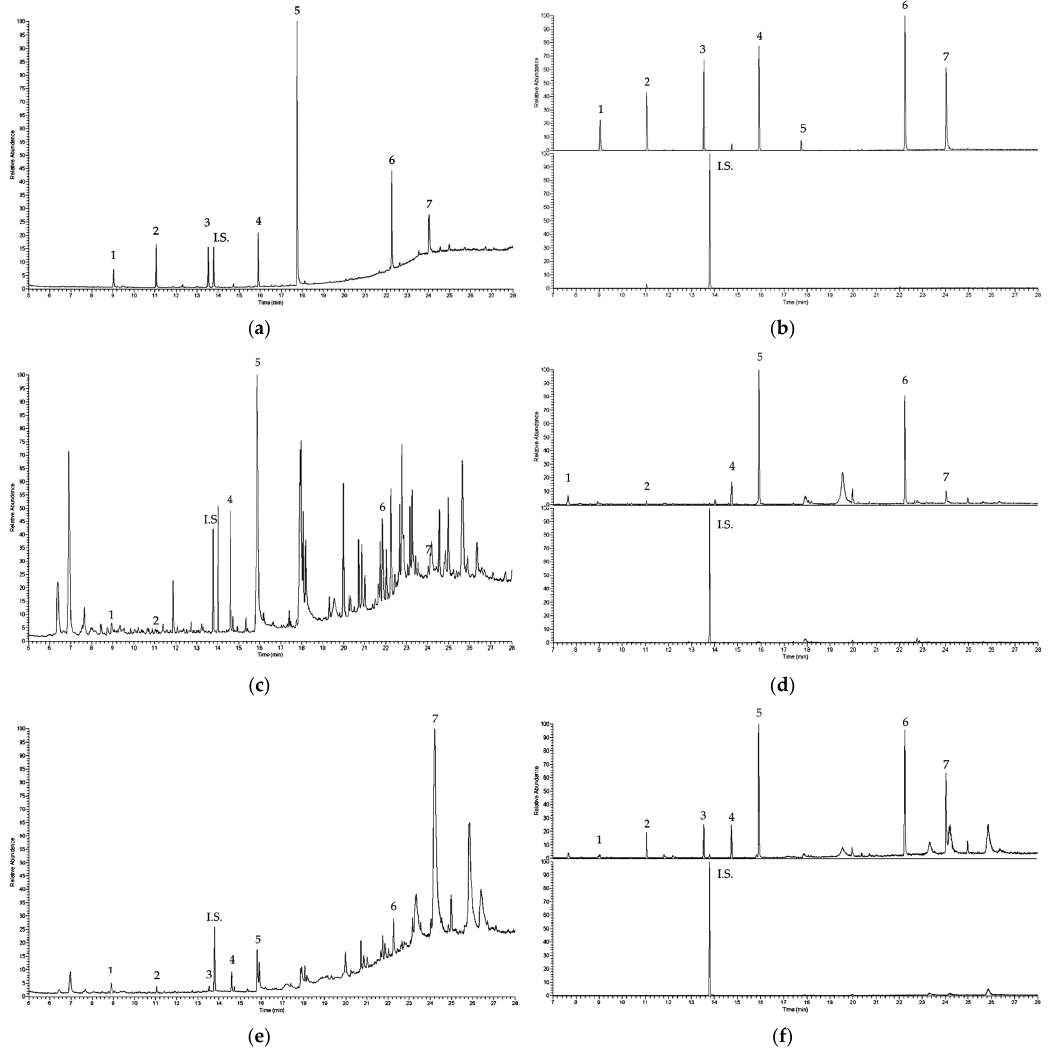
Figure 3. GC–IT/MS profiles a PAE standard solution (0.1 µg mL − 1 ) ( a , b ), a coffee sample ( c , d ), and the same coffee sample spiked with a PAE standard solution 0.1 µg mL − 1 ( e , f ) in Total Ion Chroma- togram (TIC) and Selected Ion Monitoring (SIM), respectively. For peak identification: 1. DMP (t r 8.99 min); 2. DEP (11.03 min); 3. DiBP (13.5 min); 3. I.S. (phenanthrene) (13.81 min); 4. DBP (14.72 min); 5. DEHP (15.89 min); 6. DNOP (22.23 min); 7. DDP (24.00 min). For acronyms: see Table 1. For experimental conditions: see text.